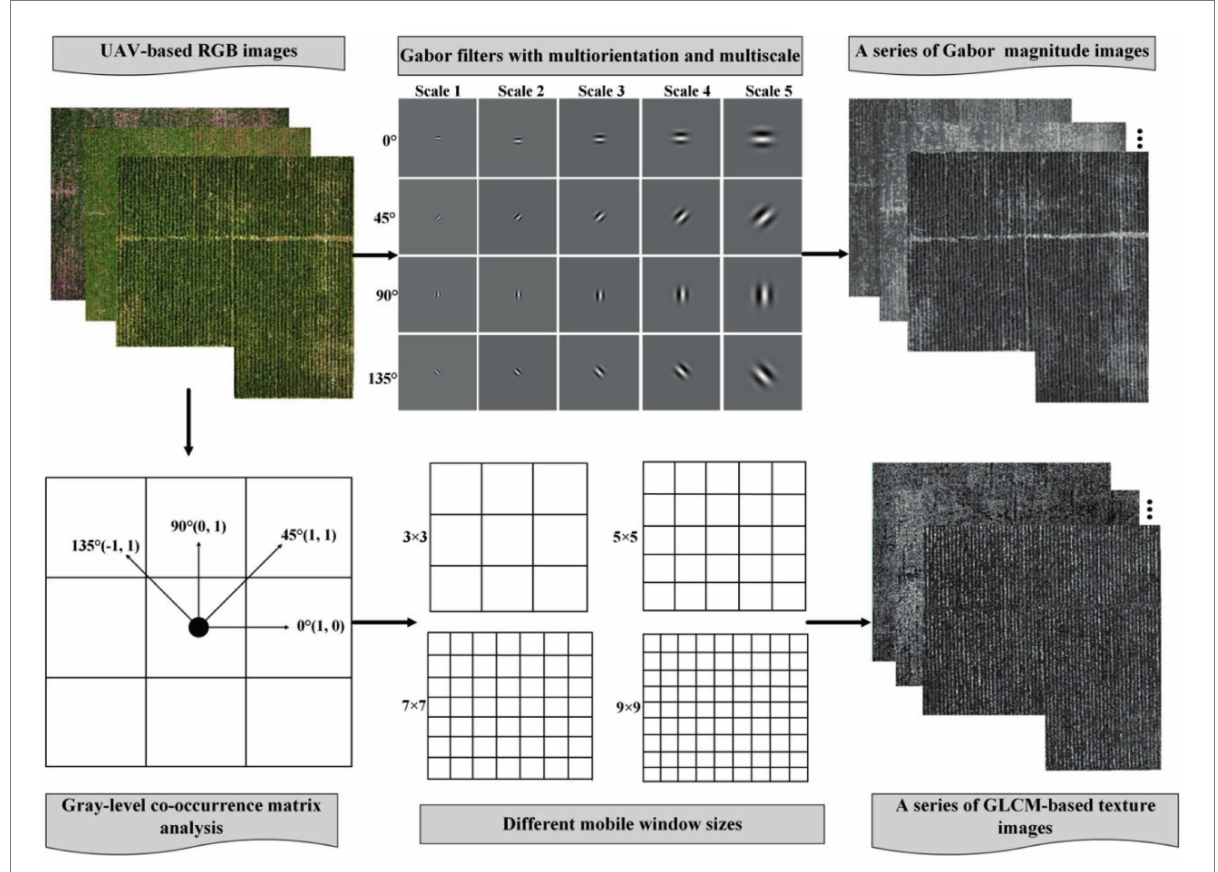
FIGURE 3 Multiform texture features extraction process from GLCM- and Gabor-based